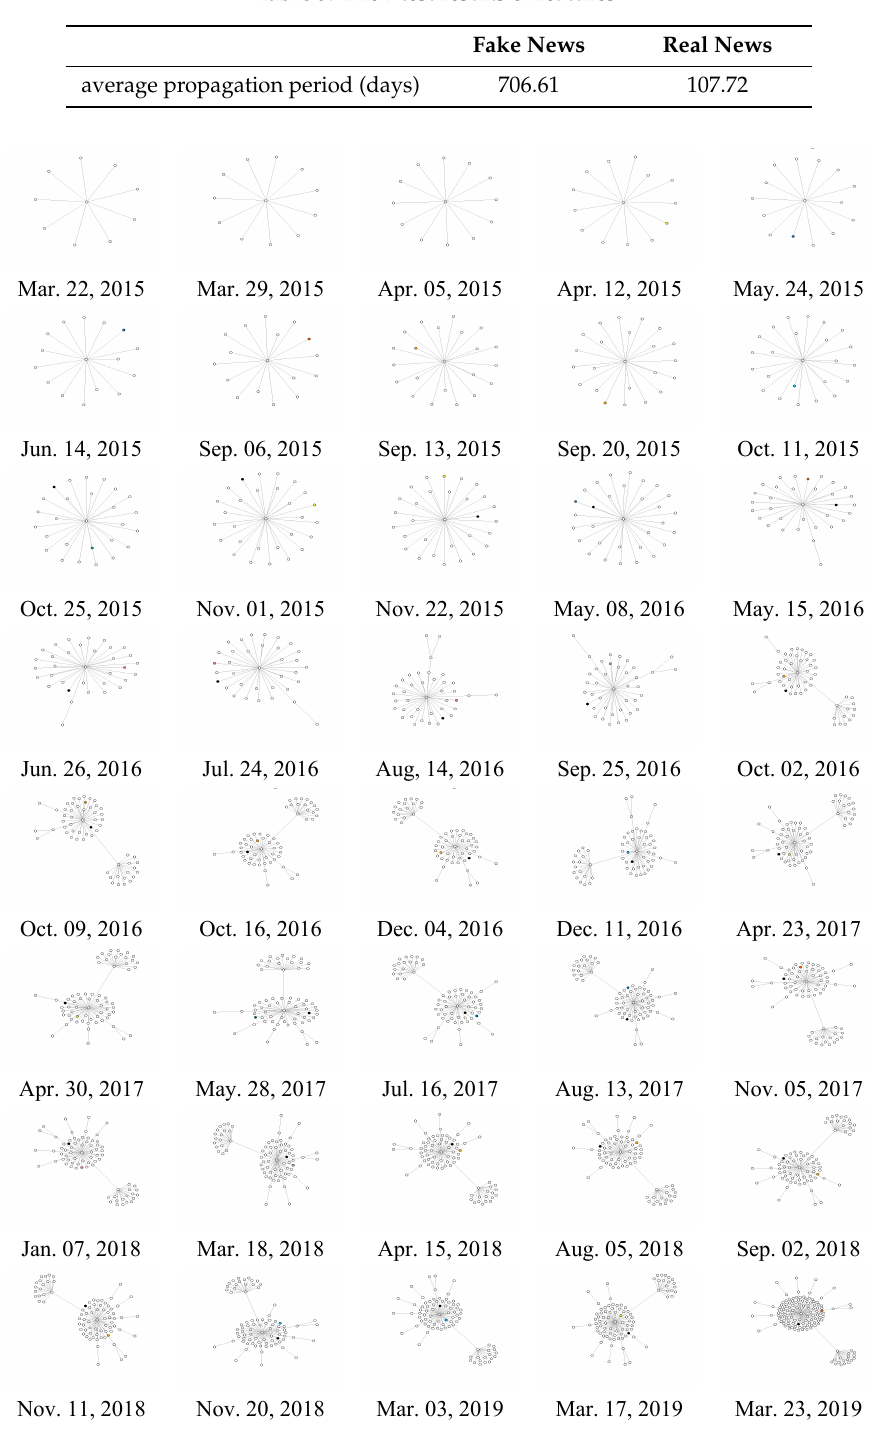
Table 5. The t -test results of features.